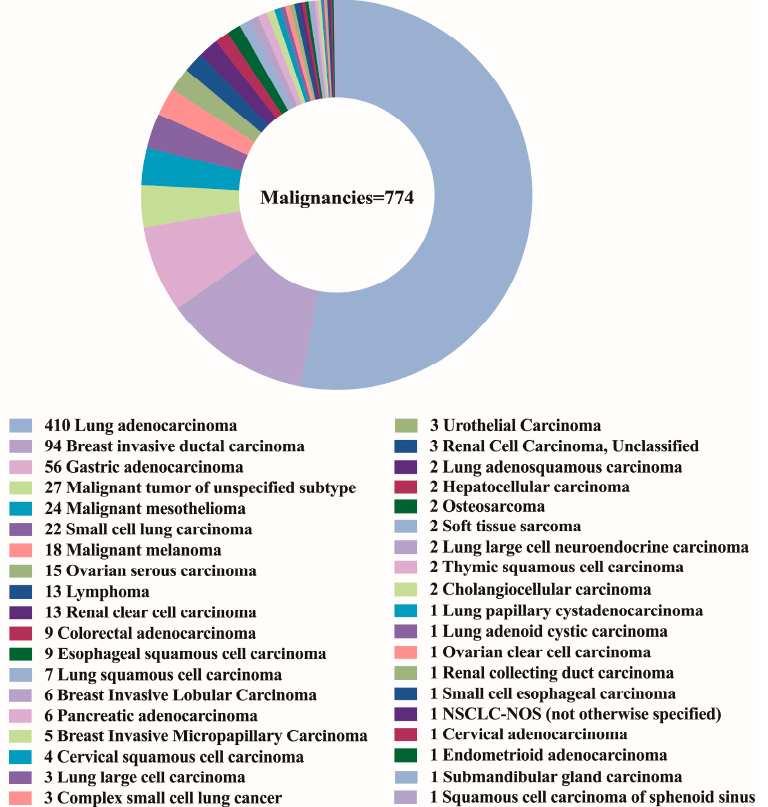
Figure 4. The specific pathological categories of 774 cases of malignant pleural effusion.